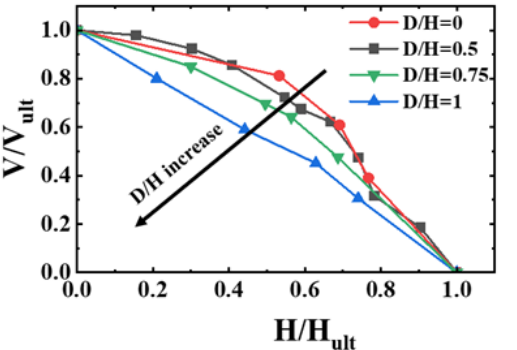
Figure 23. Normalized V-H failure envelope of gravity anchors at different mooring heights.